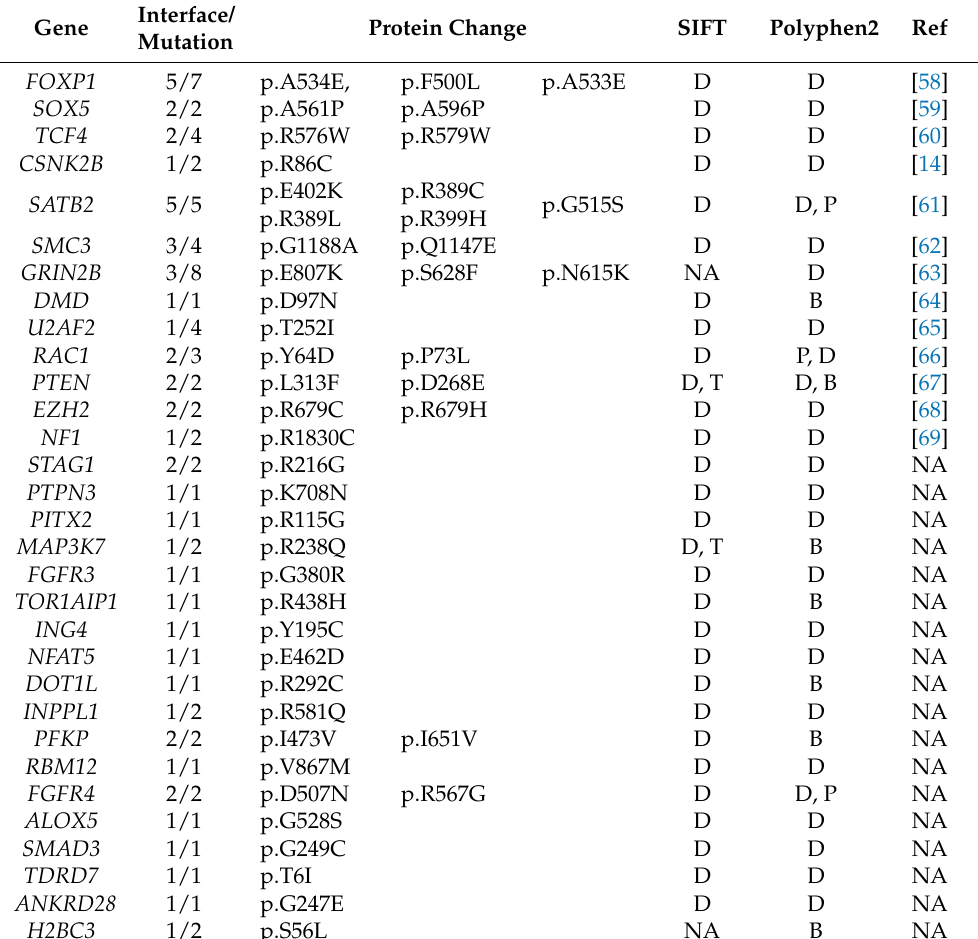
Table 1. Cont. Gene